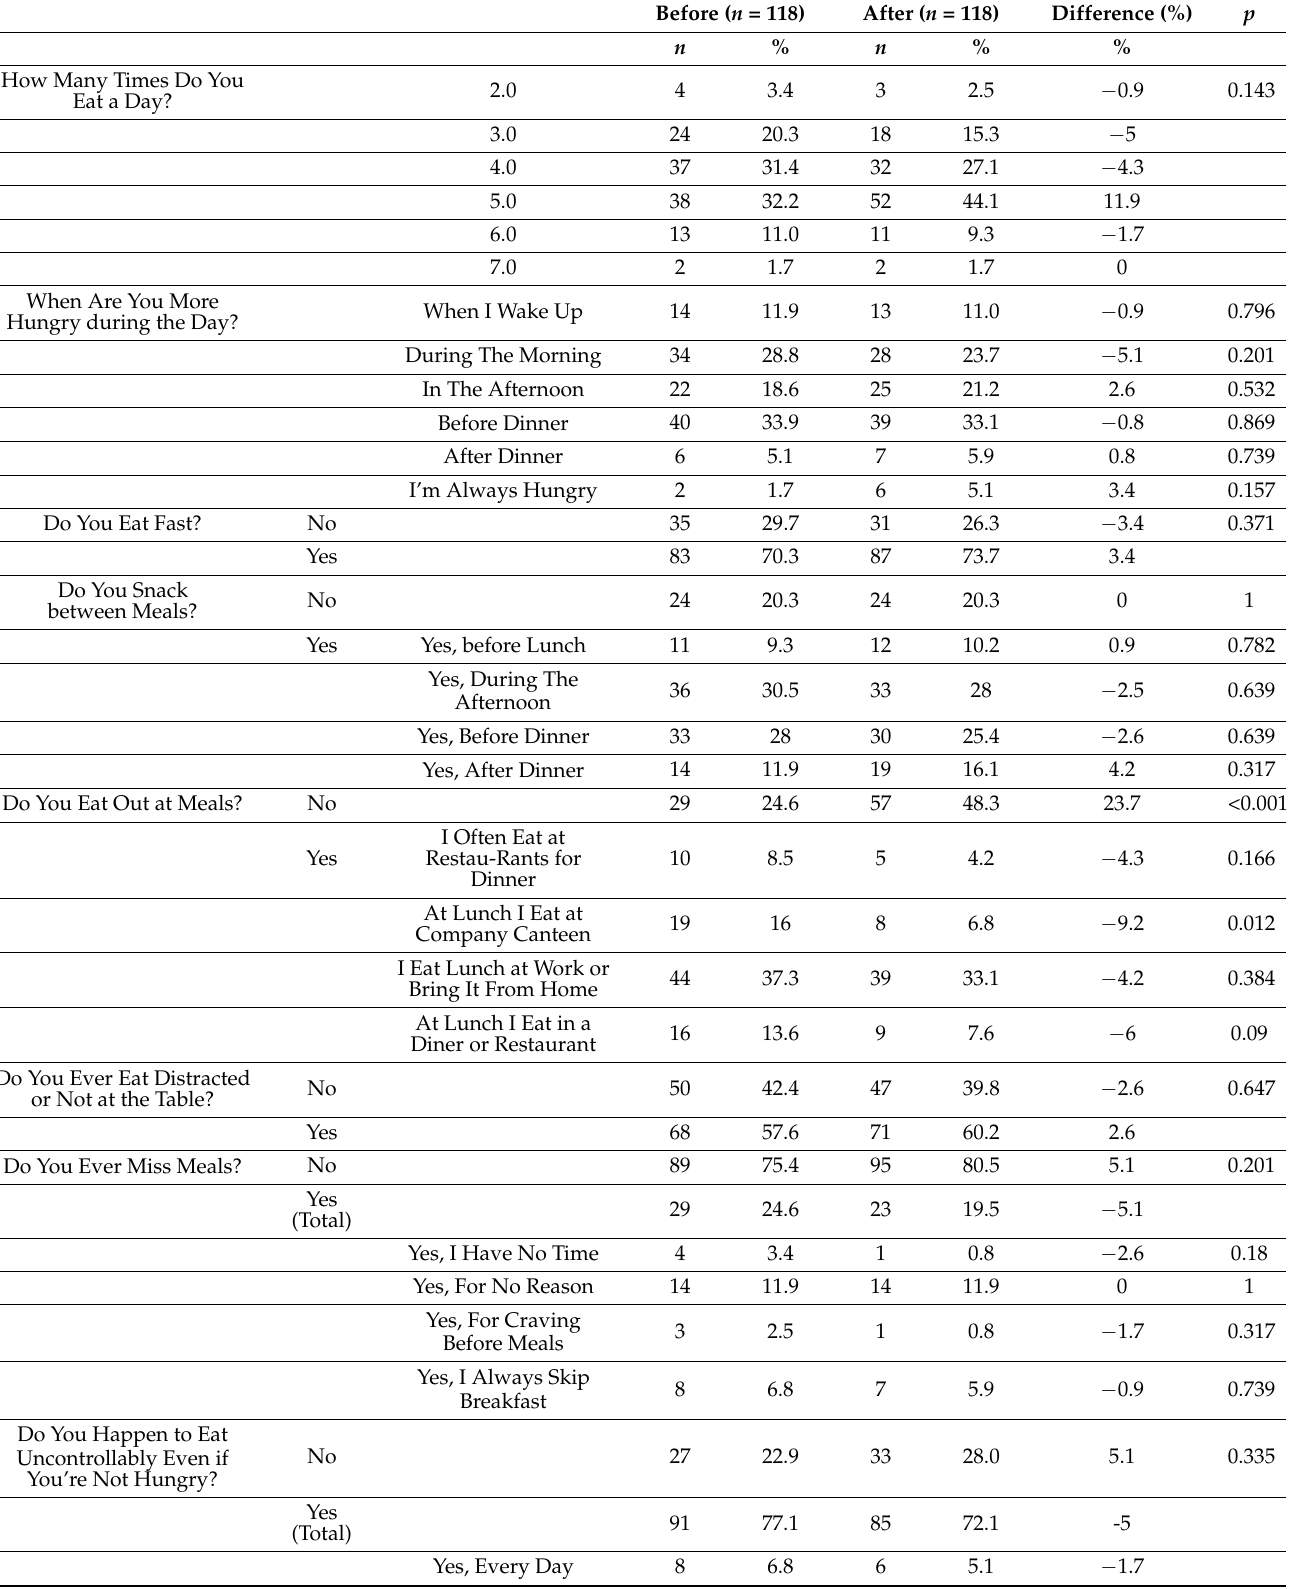
Table 4. Meals, sleep habits, and sports frequency differences before and after